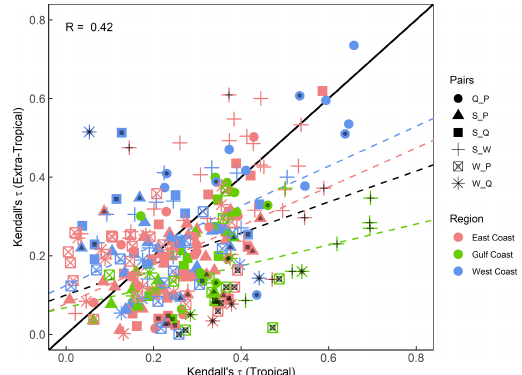
Figure 5. Scatterplot comparing dependence derived with Kendall’s τ and two-way sampling, using seasonal maxima ap- proach for tropical and extra-tropical seasons. Colours denote the location (separated into East, Gulf, and West coasts), and mark- ers represent the different variable pairs. Black dots on the mark- ers indicate the significant difference in dependence between sea- sons. Dashed lines show linear regression fits corresponding to all data points (black) and for different subsets according to locations (coloured as outlined in the